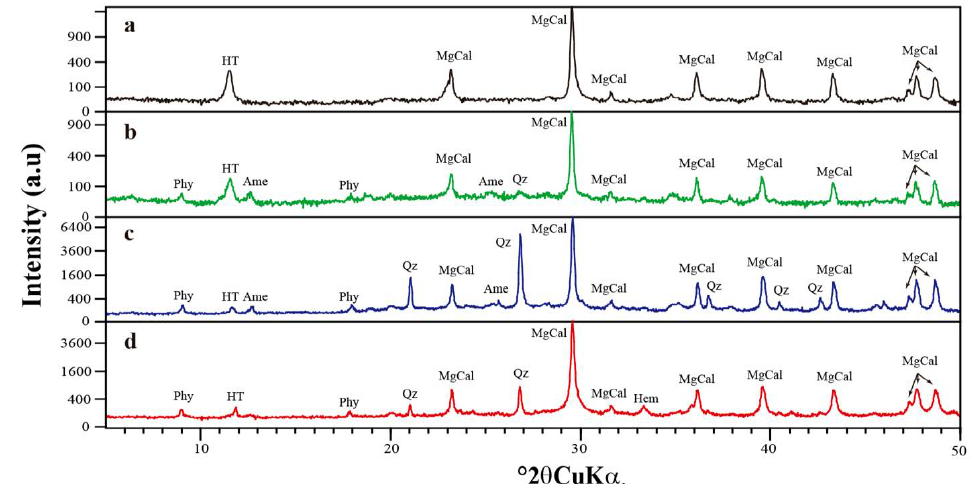
Figure 5. X-ray diffraction patterns of the lime mortars from Amaiur Castle cistern. ( a ) Binder fraction < 2 µ m from the lunette. ( b ) Binder fraction < 2 µ m from the structural mortar of the tank. ( c ) Bulk fraction from the inner layer of the plaster mortar. ( d ) Bulk fraction from the pigmented layer of the plaster mortar. Ame: amesite, Hem: hematite, HT: hydrotalcite; Mg-cal: magnesium calcite, Phy: phyllosilicates s.l., Qz: quartz.